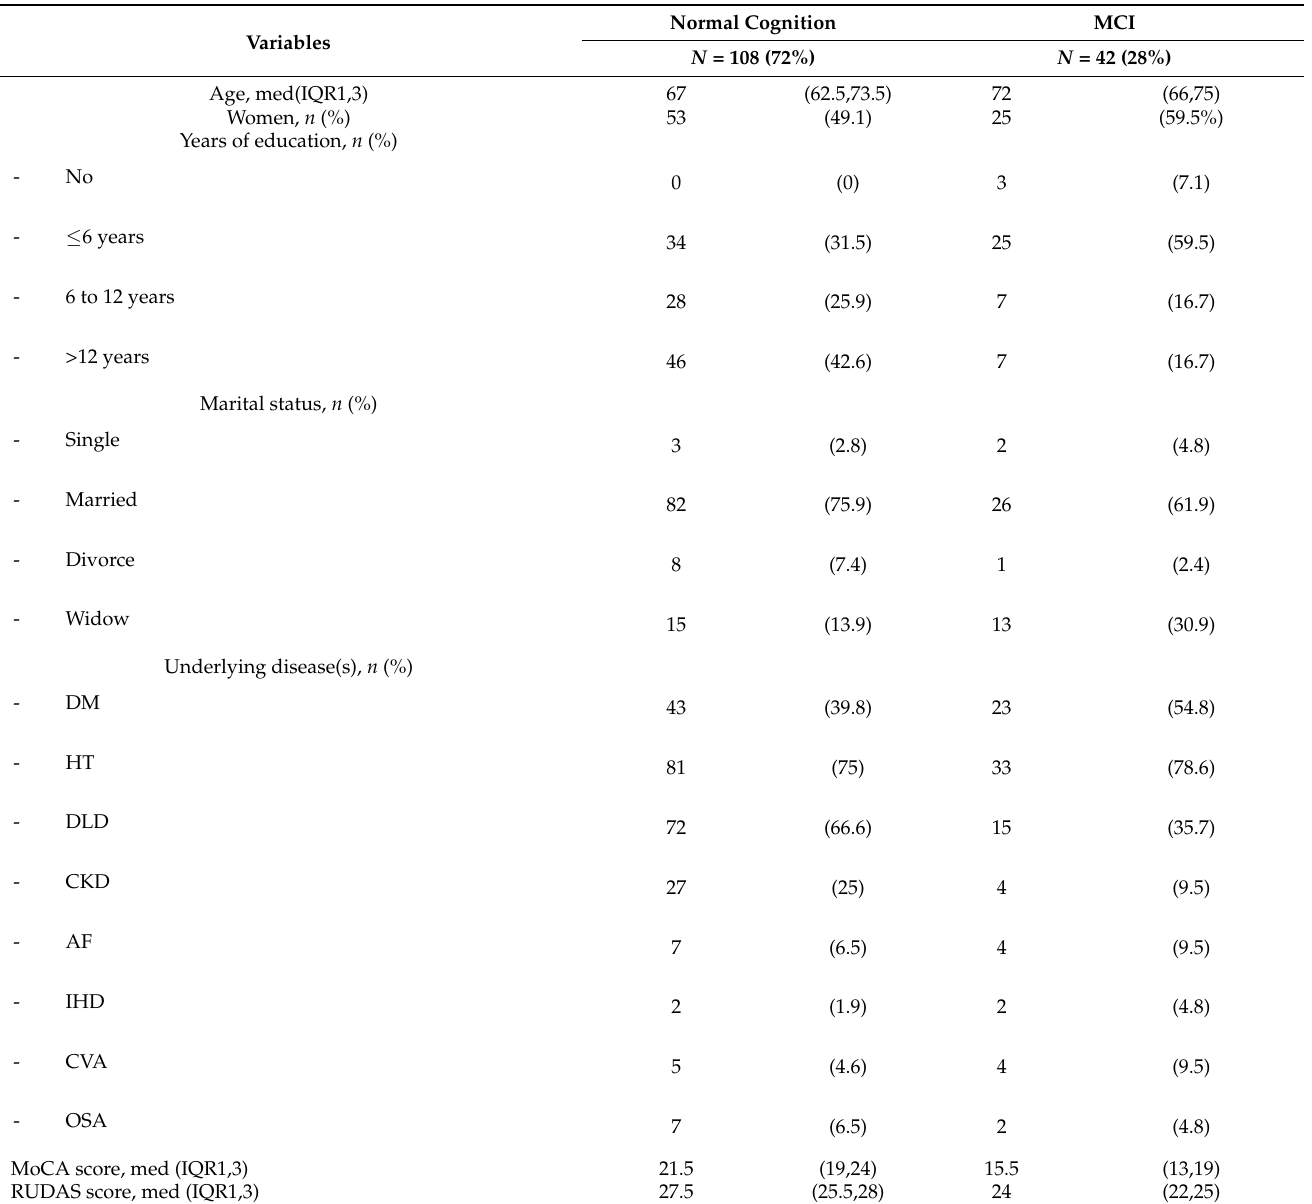
Table 1. Baseline data of the